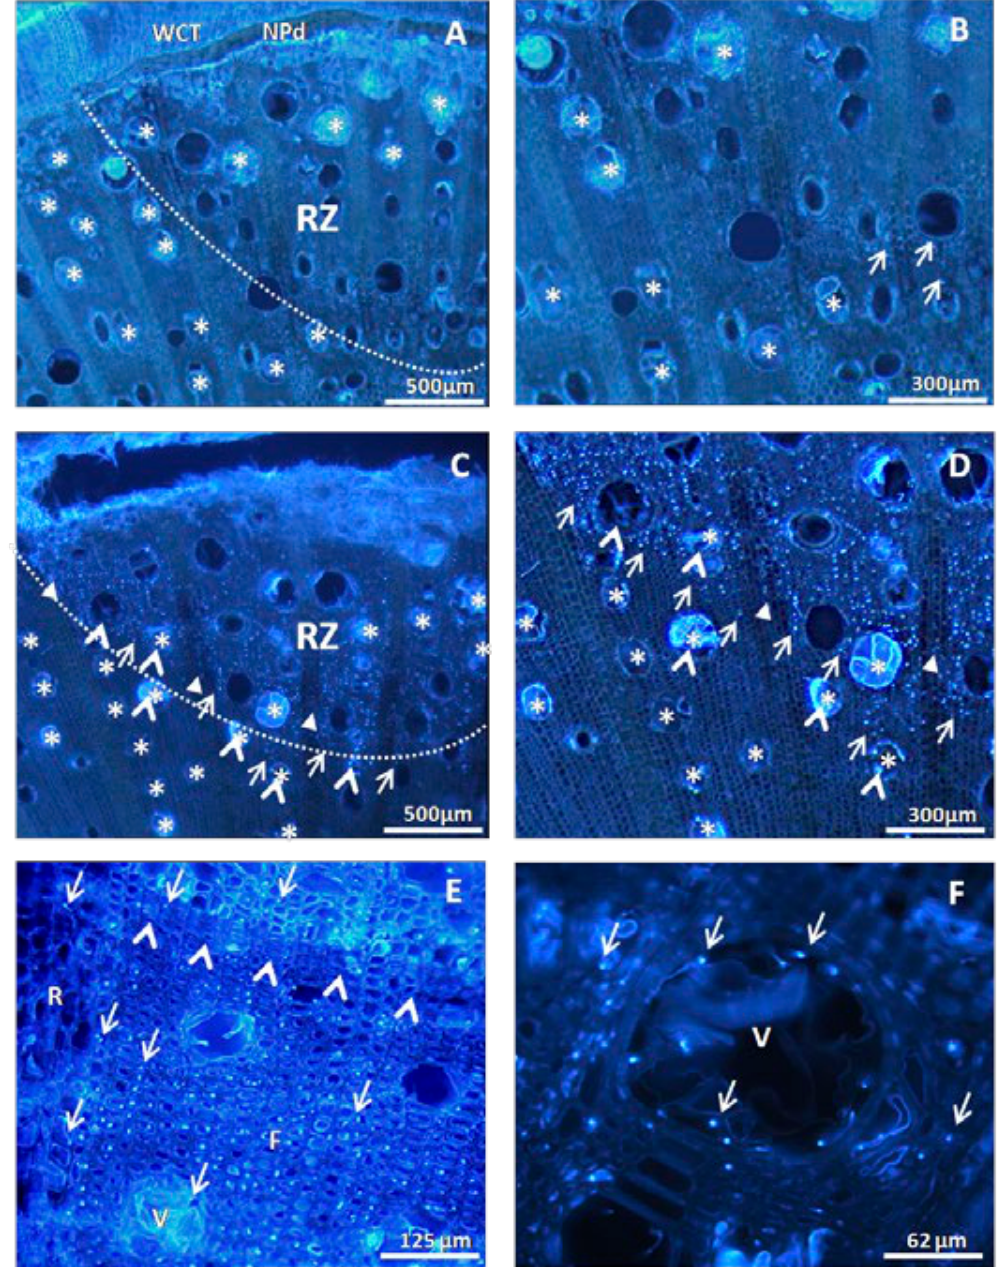
Figure 3. Localization of Pch hypha in xylem. (A–F) Epifluorescence micrographs of sections stained with Calcofluor White M2R (UV illumination). (A–D) Cross sections of (A, B) wound of control plant and (C, D) of plant inoculated with Pch . Black stars indicate vessels fully occluded with tyloses, arrows indicate fungal hyphae in fibers, arrow heads indicate fun - gal hyphae in rays, V-shaped arrow heads indicate vessels where fungal hyphae occurs. (A, C) RZ boundaries are indicated by dotted lines. (E) Micrograph showing the dense network of hyphae in infected xylem. Arrow heads indicate the layer of cells delimiting the growth ring, and arrows indicate different xylem-cell types where hyphae are seen. (F) Close view of fungal hyphae (arrows) in xylem vessels occluded with tyloses. The notation F stands for fibers, NPd is for necrophylactic periderm, R is for ray, RZ is for reaction zone, V is for vessel; and WCT is for wound closure